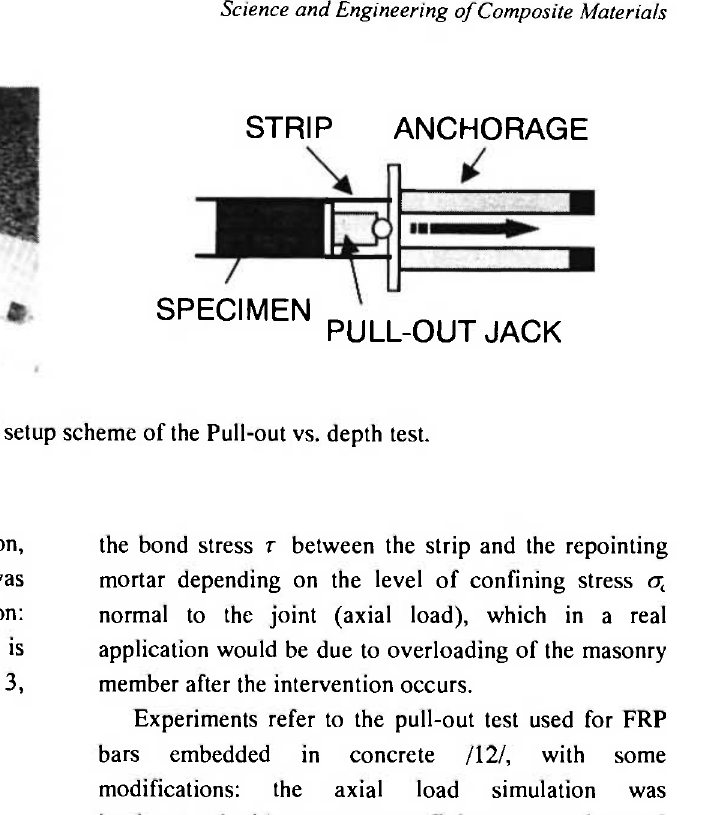
Pull-out loads vs. depth test